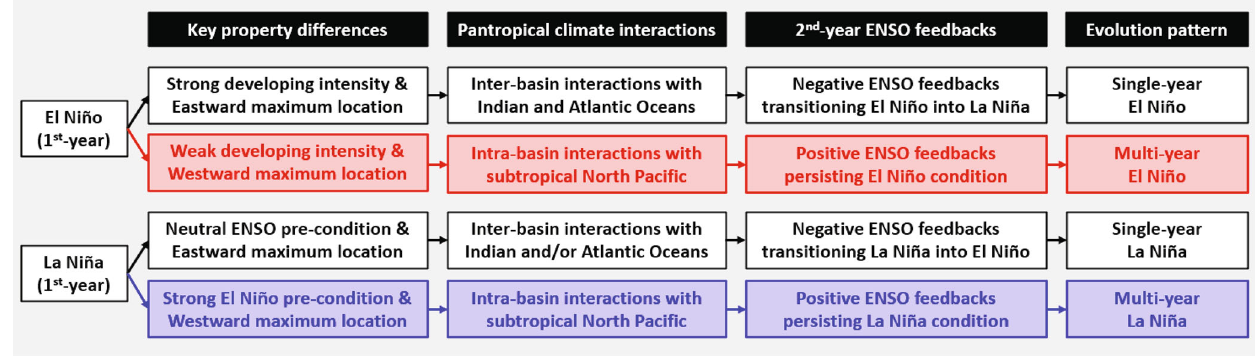
Fig. 5 Schematic diagram illustrating how the 1 st -year ENSO event evolves into either a single- or multi-year evolution event in the second year. In the diagram, key processes determining the evolution pattern of 1 st -year El Niño (two upper panels; the pathway for multi- year El Niño expressed in red) and 1 st -year La Niña (two bottom panels; the pathway for multi-year La Niña expressed in blue) are sequentially categorized as ‘ Key property differences ’ , ‘ Pantropical climate interactions ’ , ‘ 2 nd -year ENSO feedbacks ’ , and ‘ Evolution pattern ’